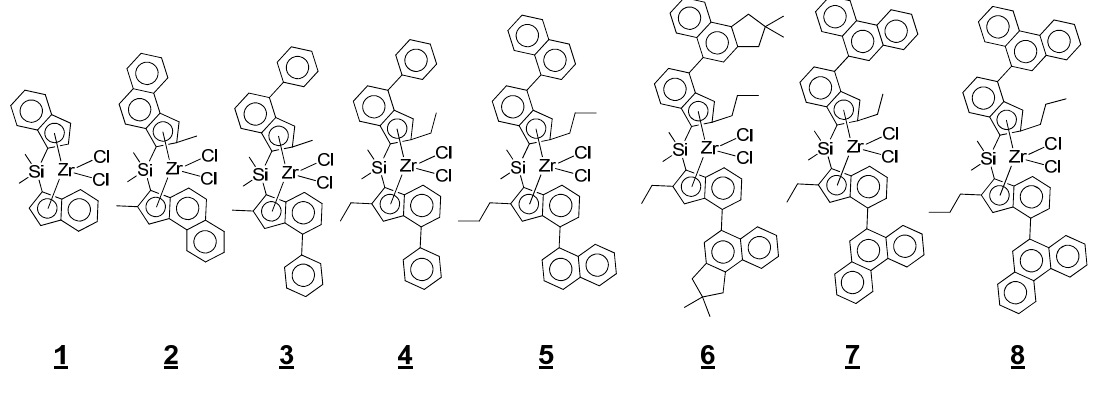
Figure 1. Ansa-zirconocene catalysts employed in this study.